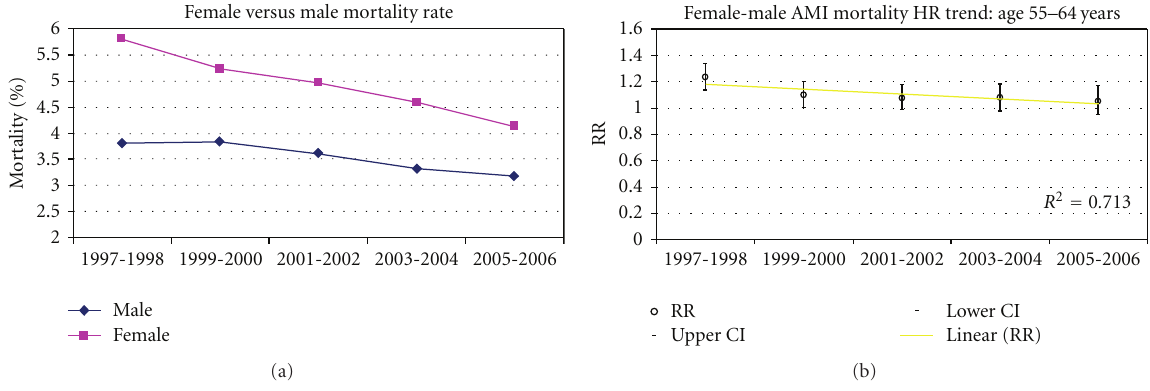
Figure 2: In-hospital AMI mortality rate and relative mortality trend (female versus male) by NIS year for age 55–64 years.